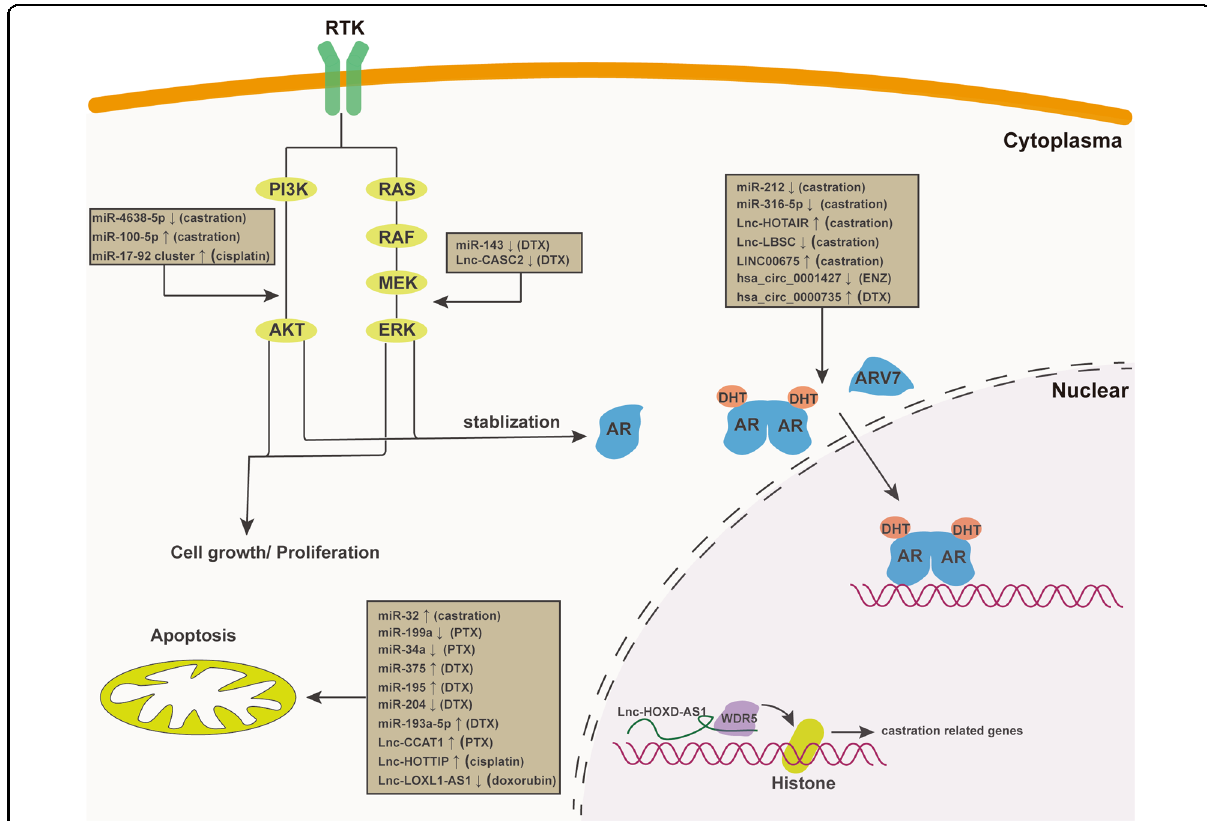
Fig. 2 Schematic presentation of noncoding RNAs which participate in drug resistance of prostate cancer. A summary diagram of noncoding RNAs participated in the drug resistance of prostate cancer. Several miRNAs, lncRNAs and circRNAs have been found to participate in drug resistance by in fl uencing RTK pathway related genes, apotptosis, AR-v7 and histone modi fi